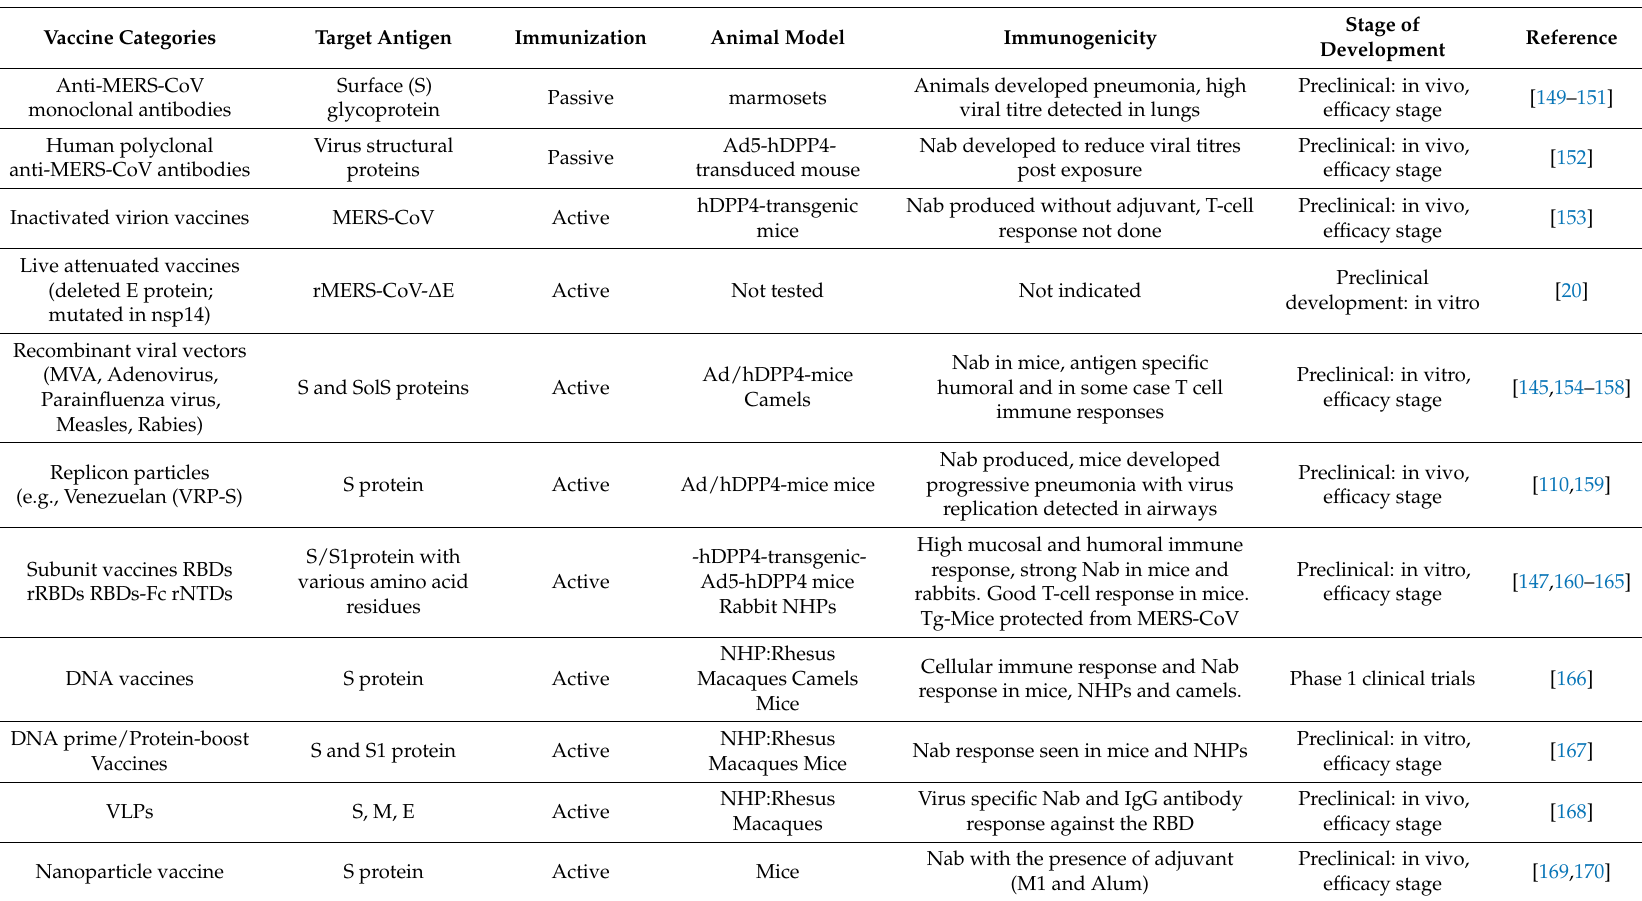
Table 2. MERS-CoV vaccines developed (adapted from